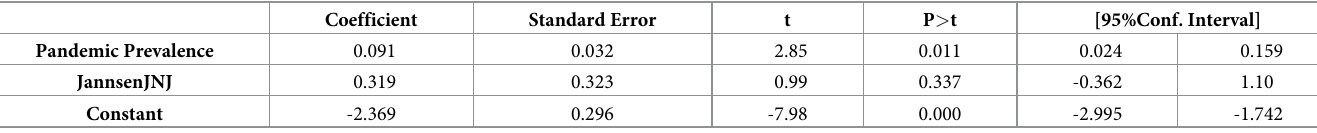
Table 4. Results of meta-regression including JanssenJNJ as a dummy variable.